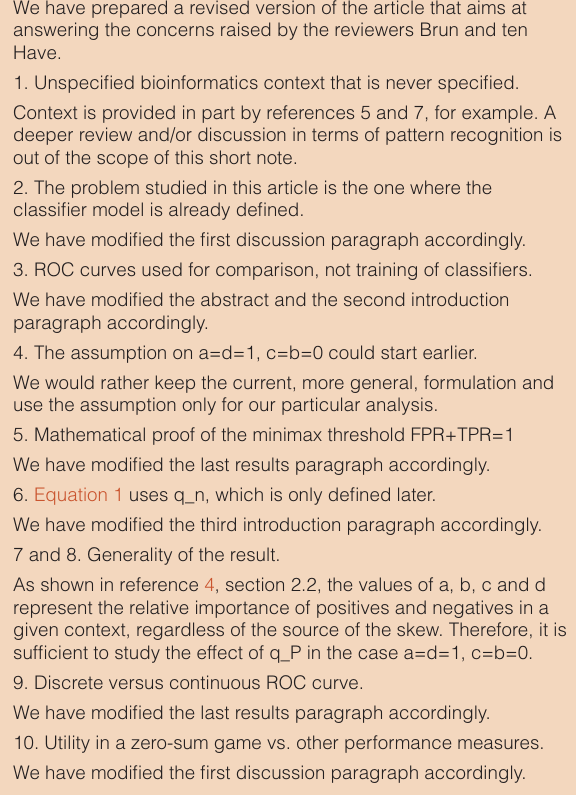
(Figure 1, continuous line). Classifier model selection often aims at